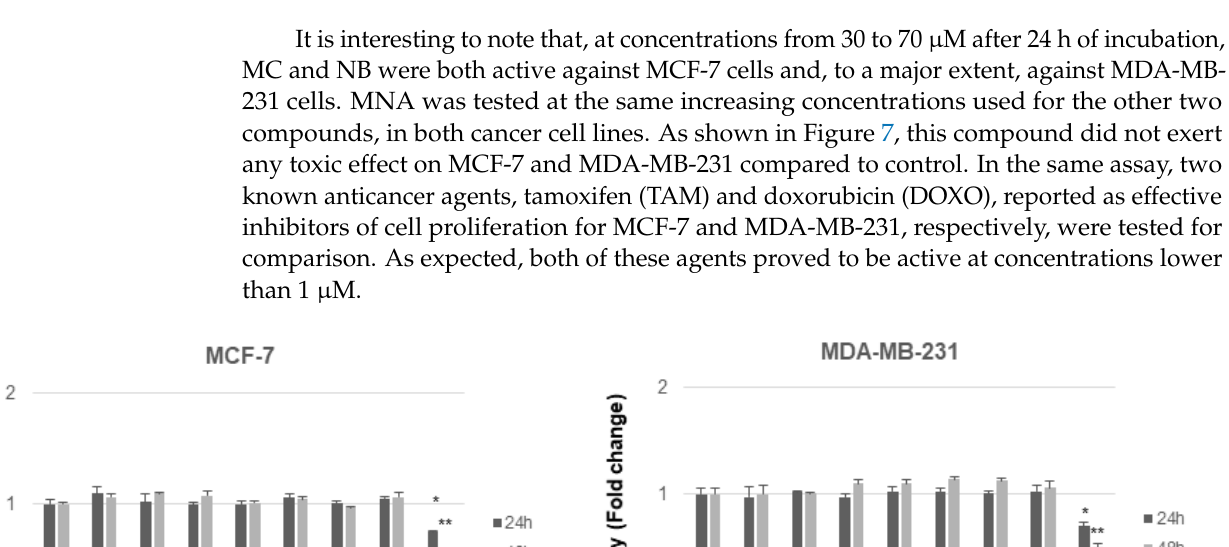
Figure 6. MTT growth assays in MCF-7 and MDA-MB-231 cells treated or not with increasing doses (1, 10, 30, 50, 70, 100, 150 µM) of NB and MC for 24 and 48 h. Cell proliferation is expressed as fold change ± S.D. relative to vehicle-treated cells and is representative of three different experiments, each performed in triplicate. Statistical significance was considered at * p < 0.05; ** p < 0.005. Statistical comparisons were drawn between groups by using a two-sample two-tailed t -test. C = control.